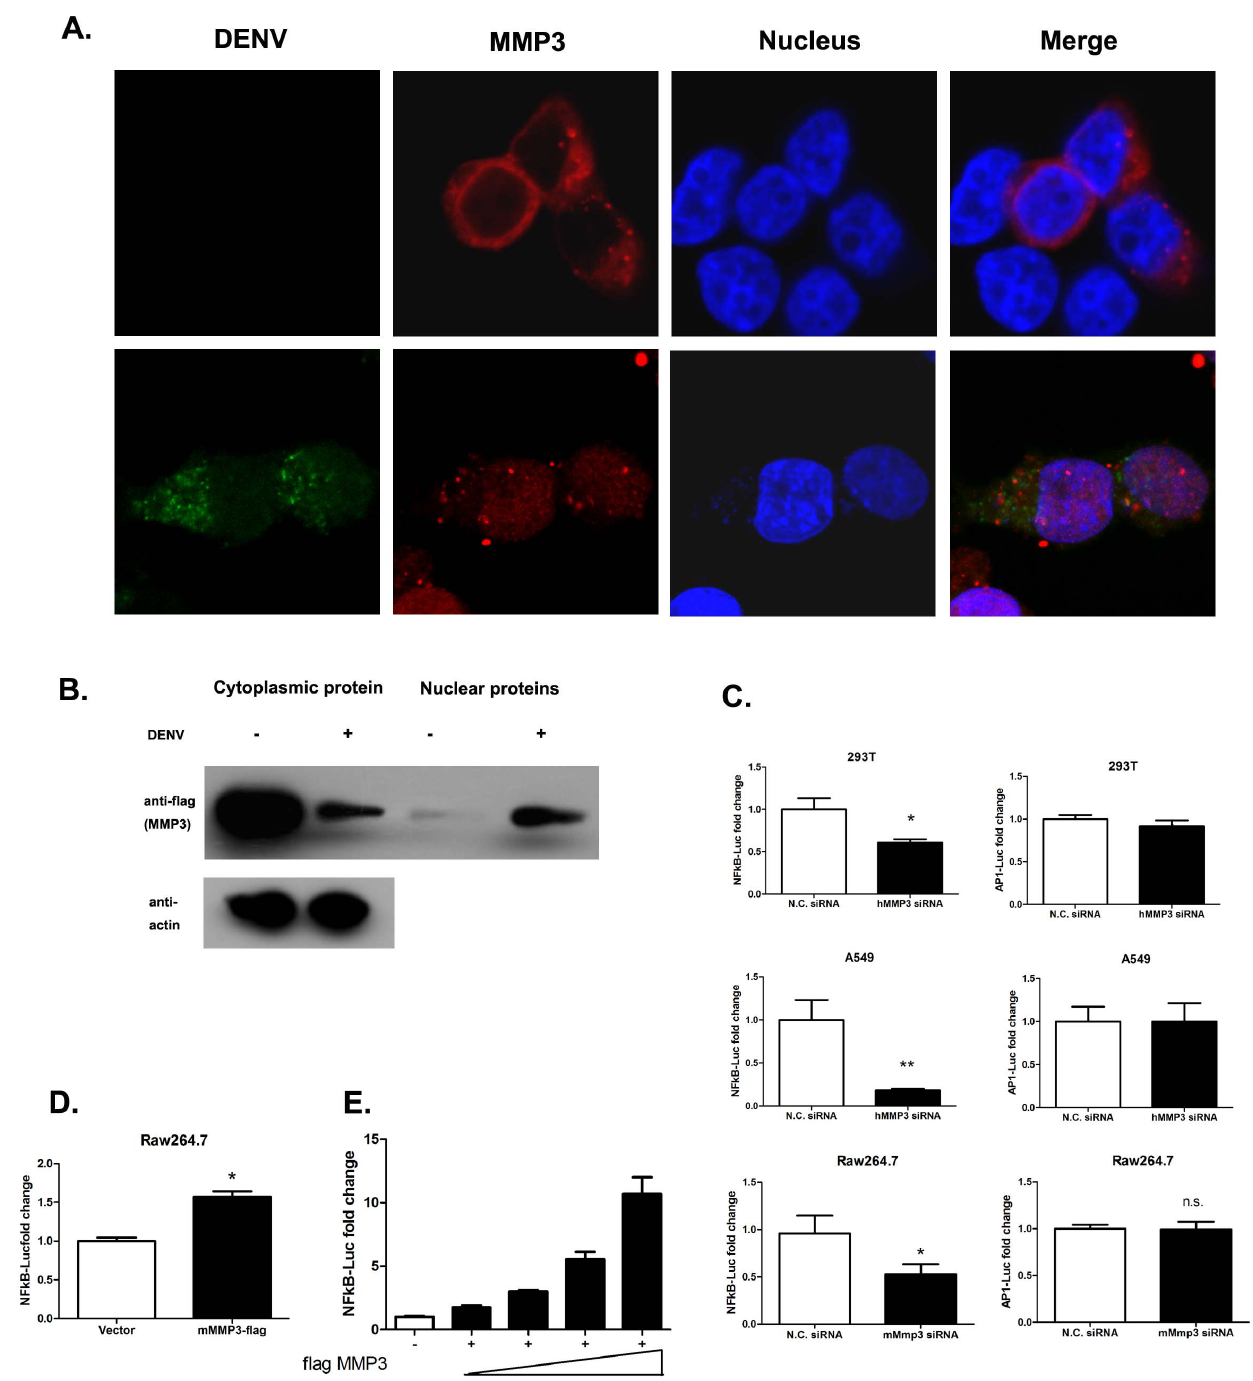
Figure 4. MMP3 moves from cell cytoplasm into nucleus upon DENV infection and influence NF k B activity. A) MMP3 moves from cell cytoplasm into nucleus upon DENV infection. B) The cytoplasmic and nuclear distribution of overexpressed flag-MMP3 in DENV infected or uninfected cells as determined by Western Blot. C)NF k B transcriptional activity is impaired upon MMP3 silencing in DENV infected 293T,A549 and RAW264.7 cells, while AP1 transcriptional activities were not influenced. D and E) Overexpression of MMP3 activates NF k B activity in DENV infected RAW264.7 (D) and 293T(E) cells. MMP3 activated NF k B in a dose dependent manner in DENV infected 293T cells(E) (MOI=1.0, 24 hrs post infection). (The reporter activities were normalized by internal control (pRL-TK Renilla luciferase value). The mean value of activities from DENV infected control cells were set to 1.0) Results are expressed as the mean + the SEM. * p , 0.05 and ** p , 0.01 ( t -test). Representative results from at least 3 independent experiments.